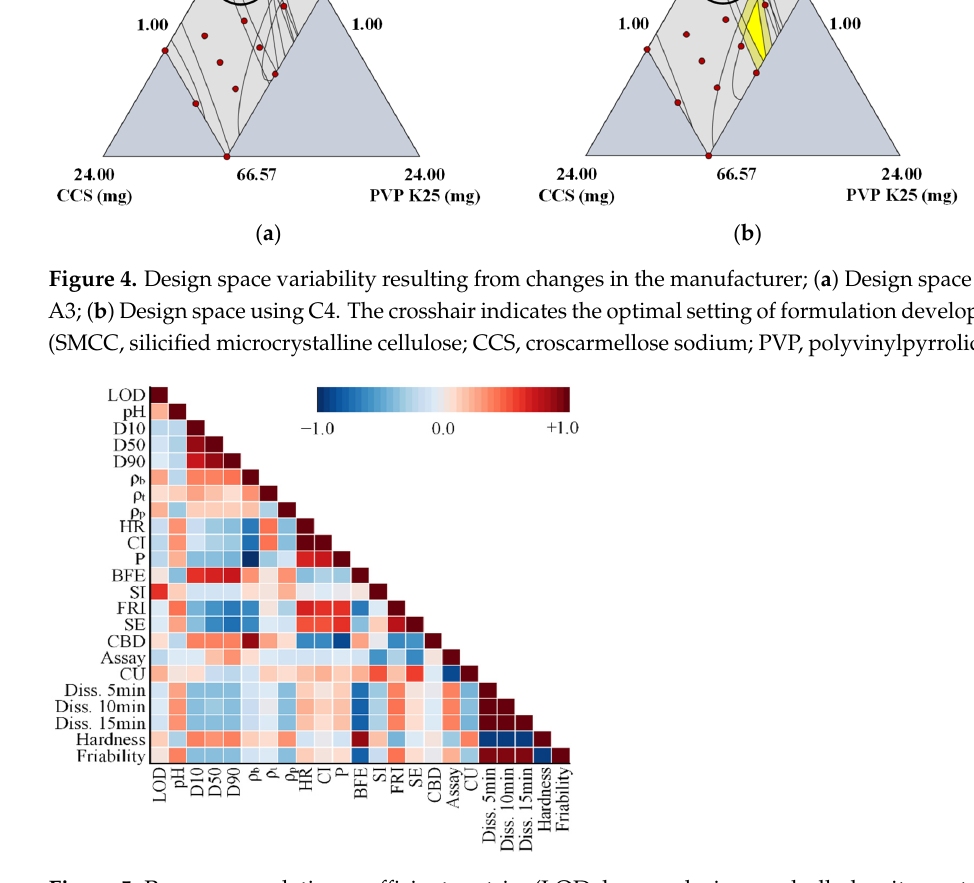
Figure 5. Pearson correlation coefficient matrix. (LOD, loss on drying; ρ b , bulk density; ρ t , tapped density; ρ p , true density; HR, Hausner ratio; CI, compressibility index; P, powder porosity; BFE, basic flowability energy; SI, stability index; FRI, flow rate index; SE, specific energy; CBD, conditioned bulk density; CU, content uniformity; Diss., dissolution).